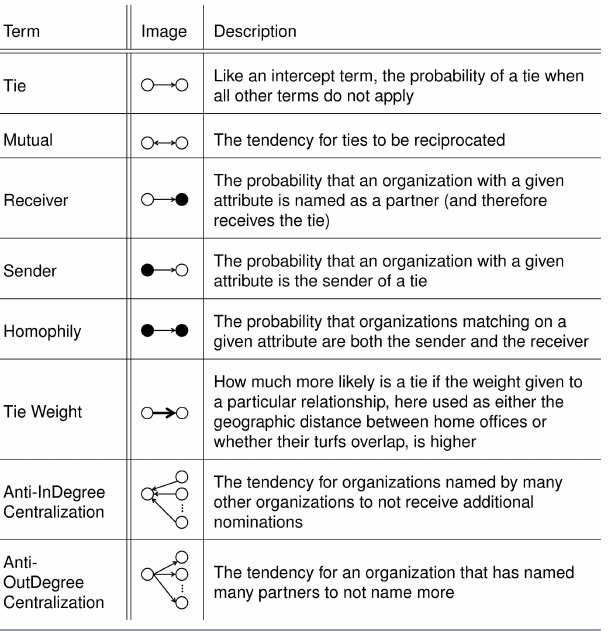
Fig. 1 . Terms used in the exponential random graph models.